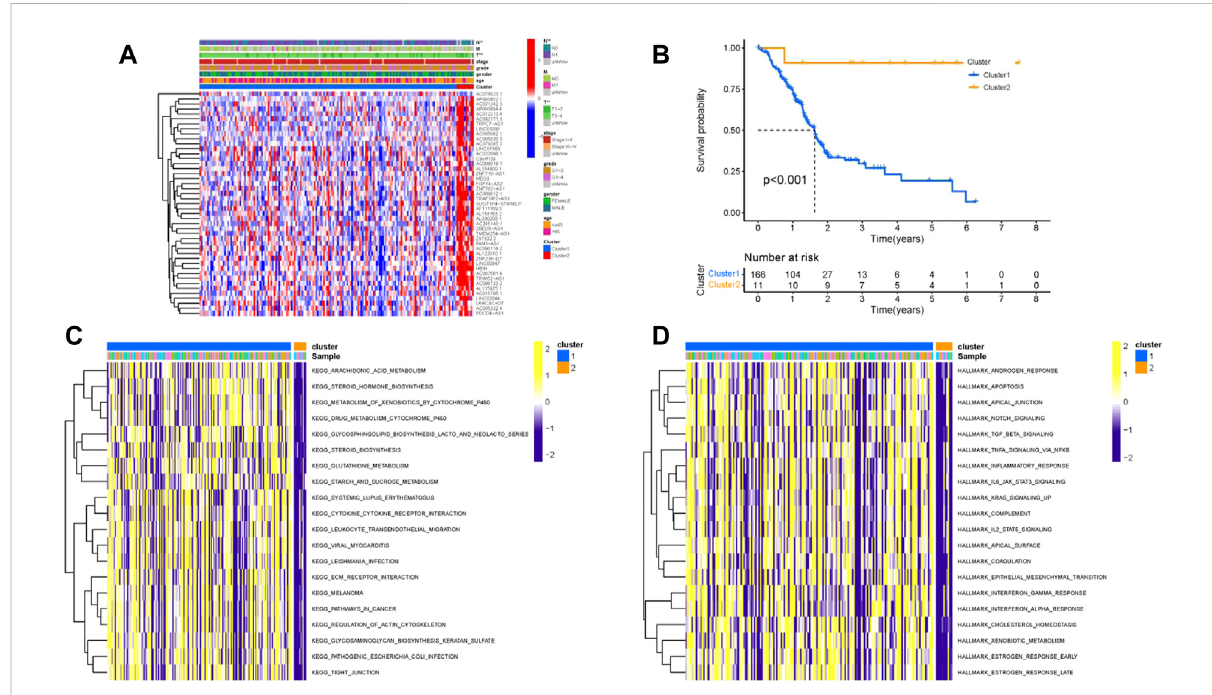
FIGURE 4 Clustering of prognostic m6A-related lncRNA expression pro fi ling. (A) Unsupervised clustering of prognostic m6A-related lncRNAs to classify patientsintodifferentgenomicsubtypes,termedasm6ACluster1andCluster2,respectively.Them6Aclusters,age,gender,grade,tumorstage,and TNM status were used as patient annotations. (B) Survival curves of m6A clusters were estimated by the Kaplan – Meier plotter. ( p < 0.001, log-rank test).GSVAenrichmentanalysis showed theactivation statesofbiologicalpathwaysindistinct m6Aclusters.The heatmap wasusedto visualize these biological processes; yellow represents activated pathways, and purple represents inhibited pathways. (A) KEGG; (B)